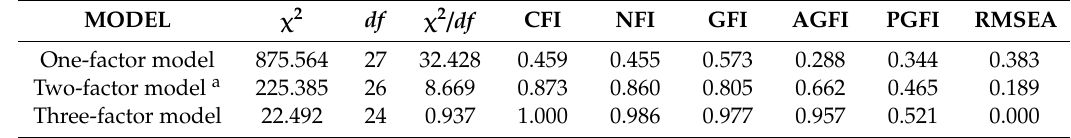
Table 1. Results of confirmatory factor analysis (CFA) of variables.